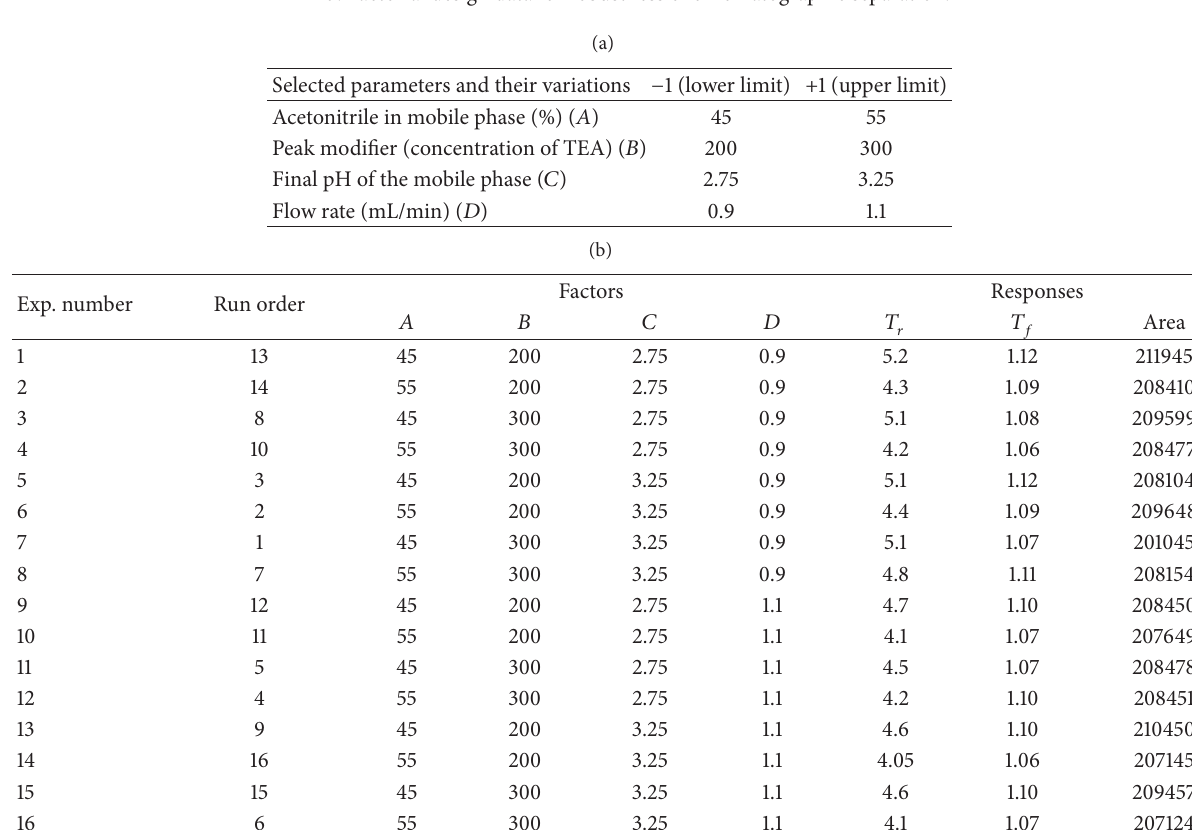
Table 5: Factorial design data for robustness of chromatographic